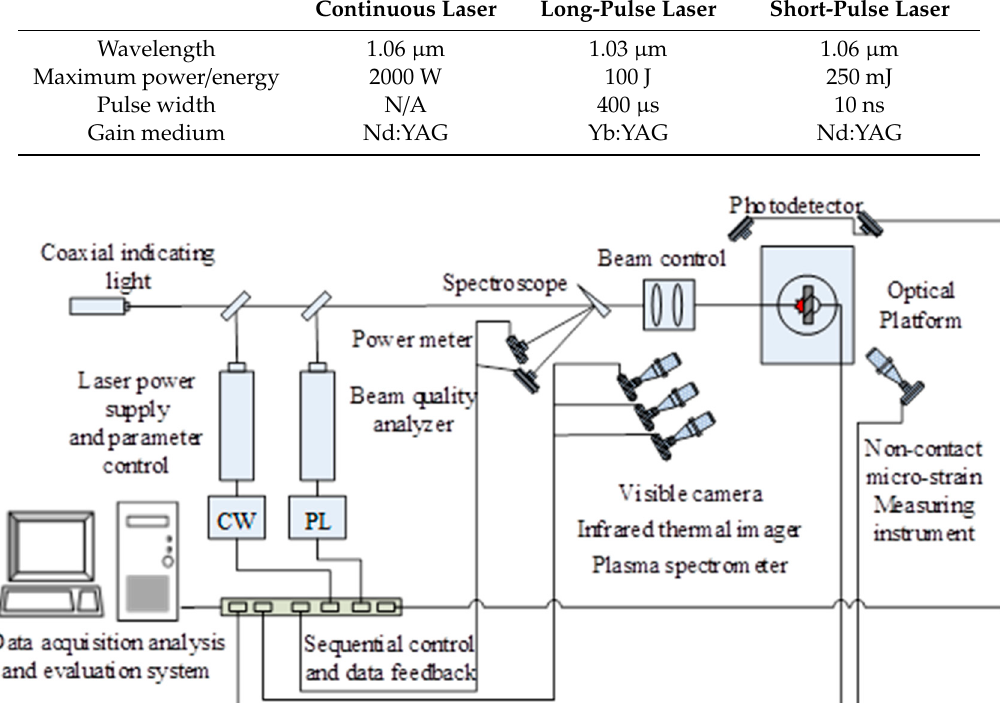
Figure 1. Laser damage effect experimental platform. Table 2. Physical properties of substrate.